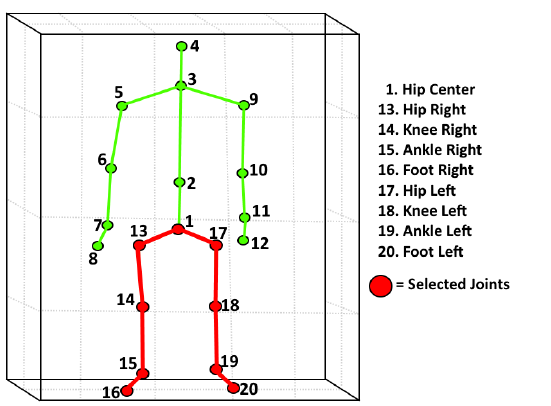
Figure 3. Lower body joints and connections selected for gait feature extraction as indicated by the red